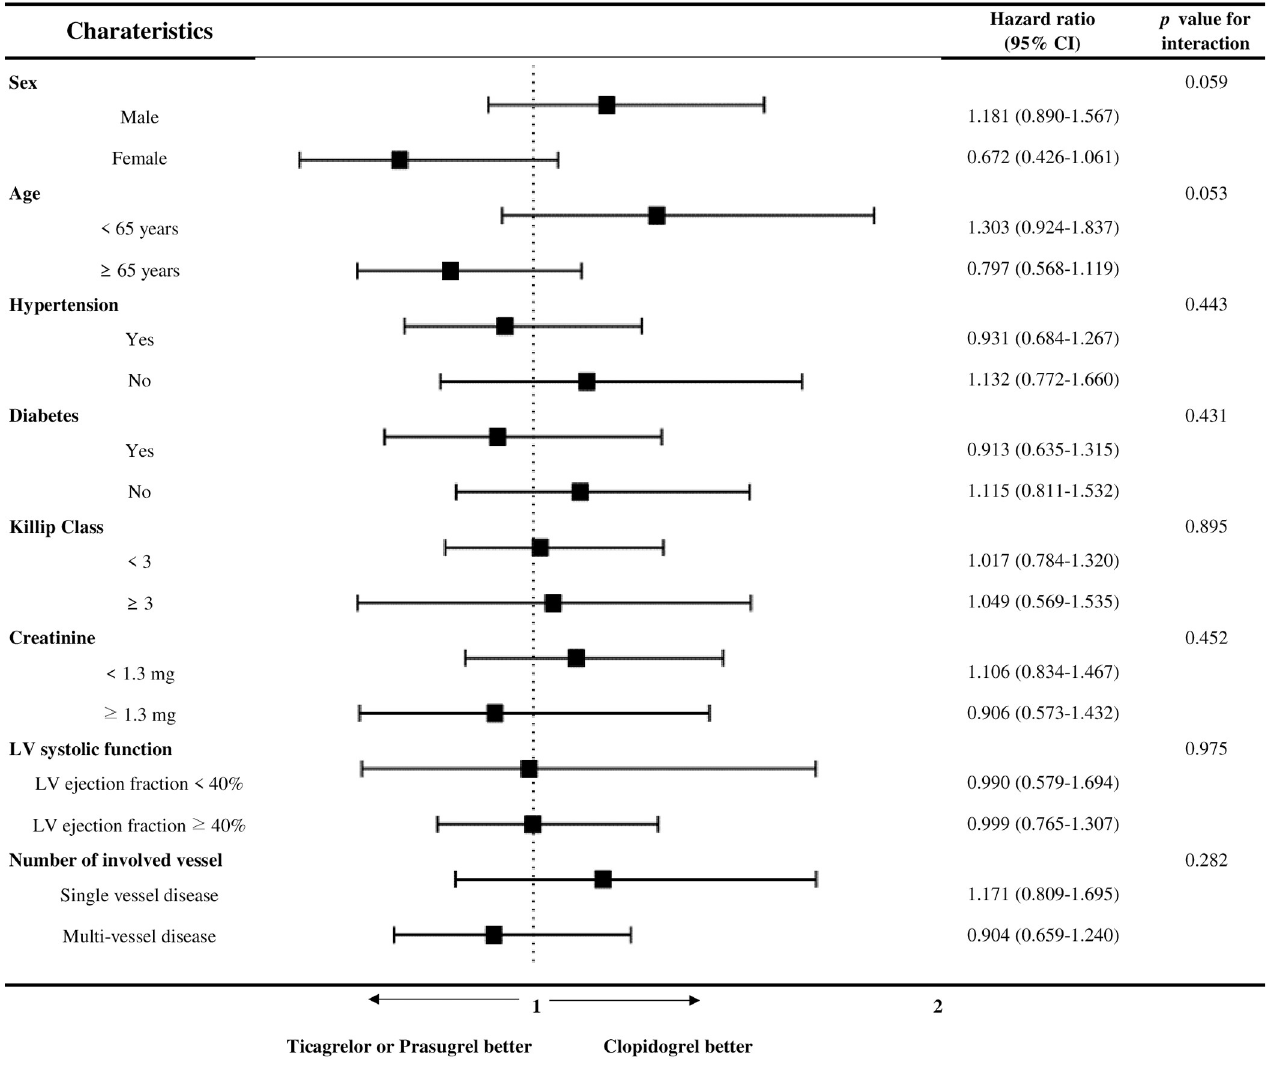
Fig 3. Forest plot of exploratory subgroup analysis between clopidogrel group and ticagrelor or prasugrel group for NACE (net adverse cardiac event). CI: confidence interval, LV: left